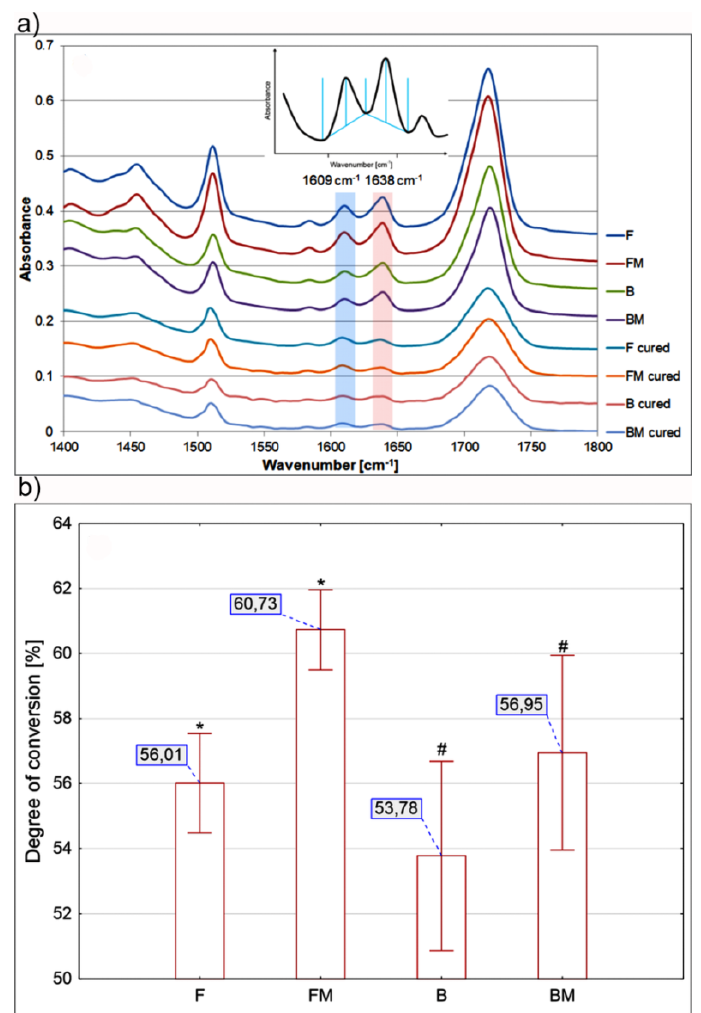
Figure 5. ( a ) Fourier Transform Infrared Spectroscopy (FTIR) with Attenuated Total Reflectance (FTIR–ATR)–ATR spectra together with the method of determining the peak height; ( b ) results of degree of conversion measurements for tested materials. Bars (I) represent standard deviation. Symbol (*) denotes statistical differences between the results obtained with F and FM sample, whereas # denotes statistical differences between the results obtained with B and BM sample.